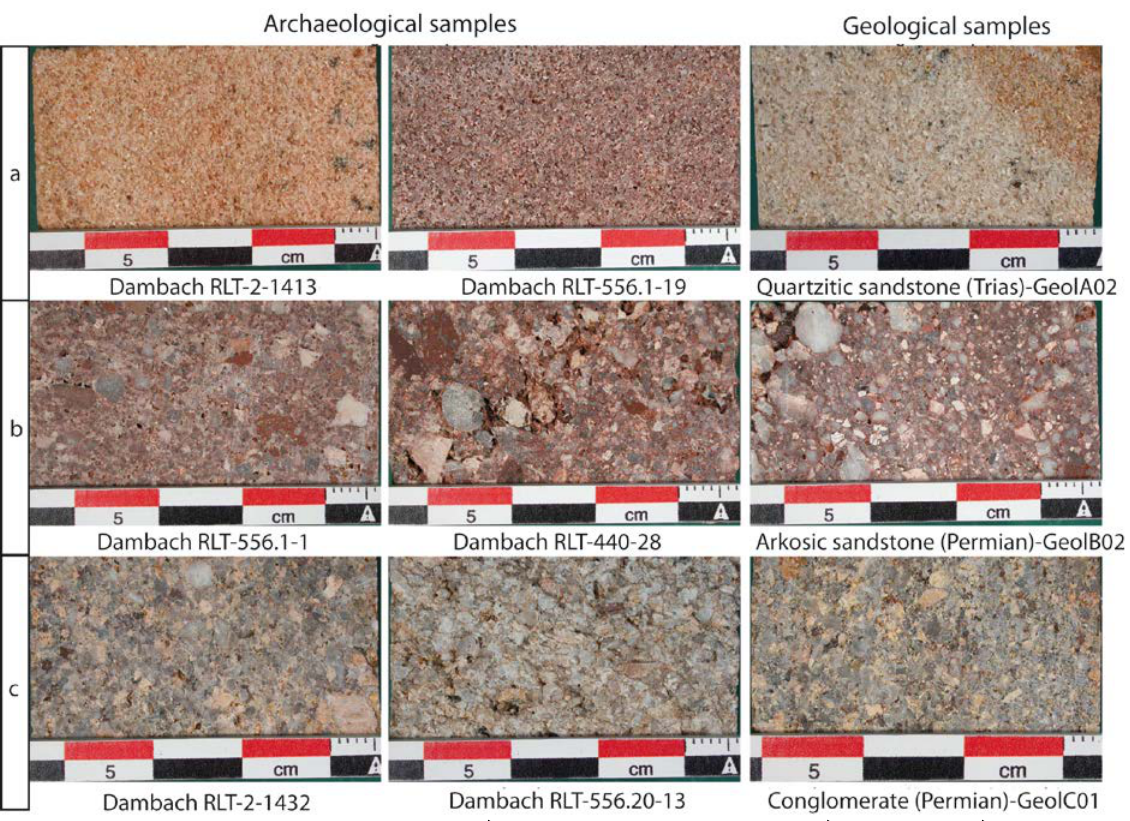
Figure 12. Macrophotograph of samples of: a) Vosges quartzitic sandstone, b) arkose and c) conglomerate (Photo: X. Drothiere & G.